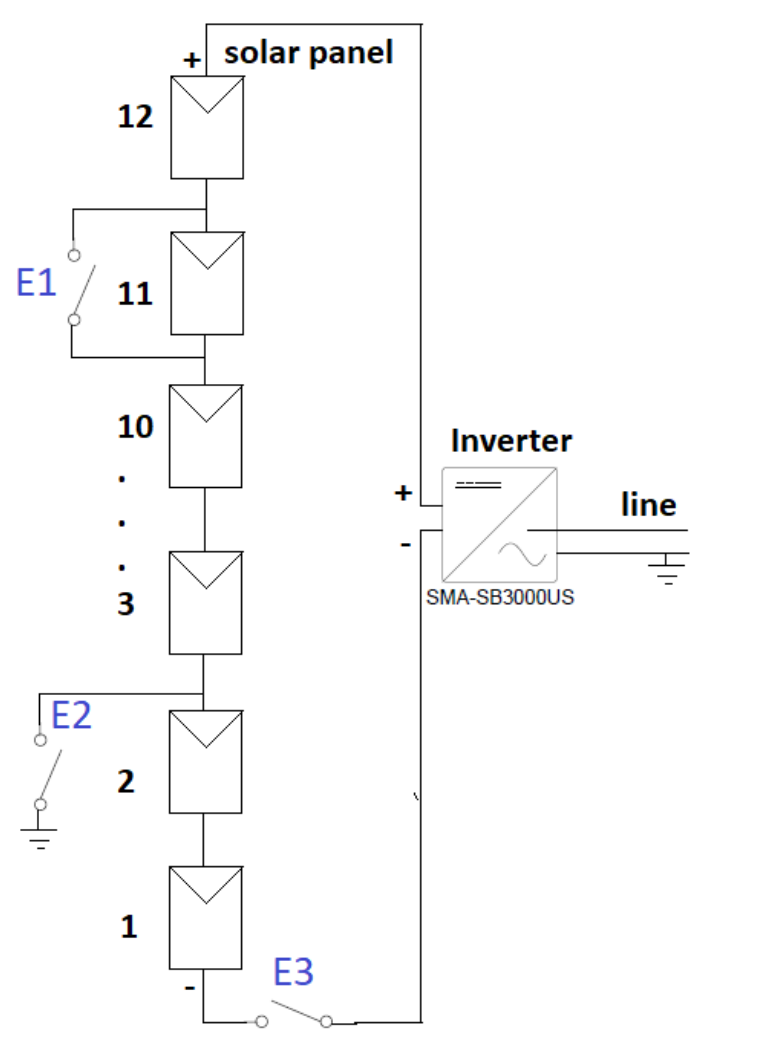
Figure 8. Diagram of the location of the switches used to generate the electrical suboptimal conditions evaluated in the